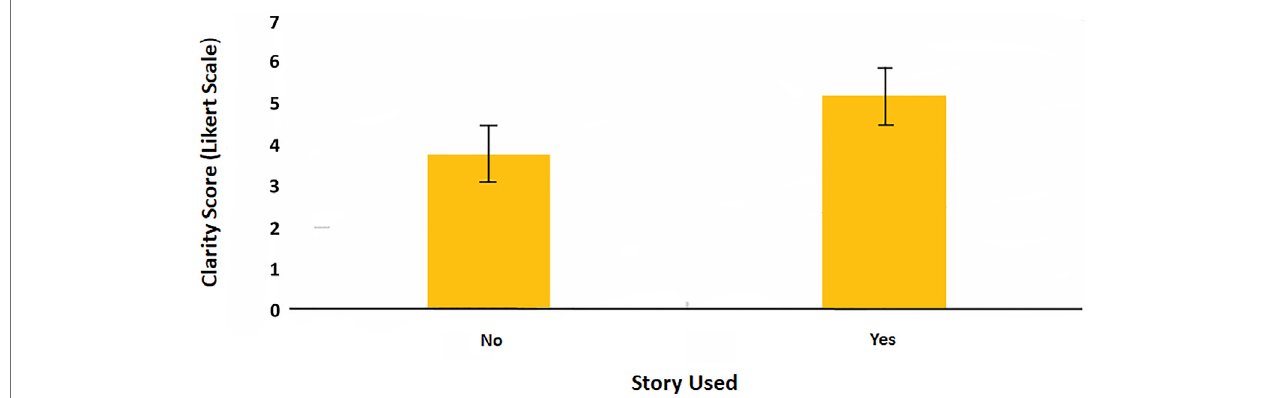
FIGURE 5 | Clarity scores for transcripts in which trainees did (right hand panel) and did not (left hand panel) use elements of story, metaphor and/or analogy.